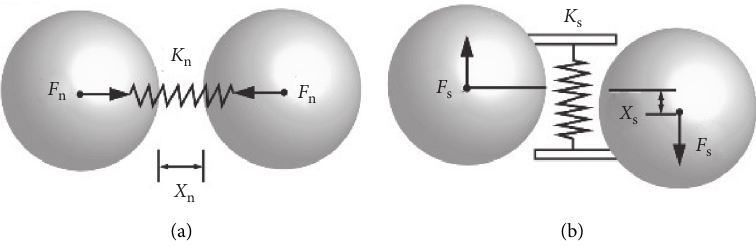
Figure 5: Linear elastic contact model. (a) Normal force between elements. (b) Shear force between